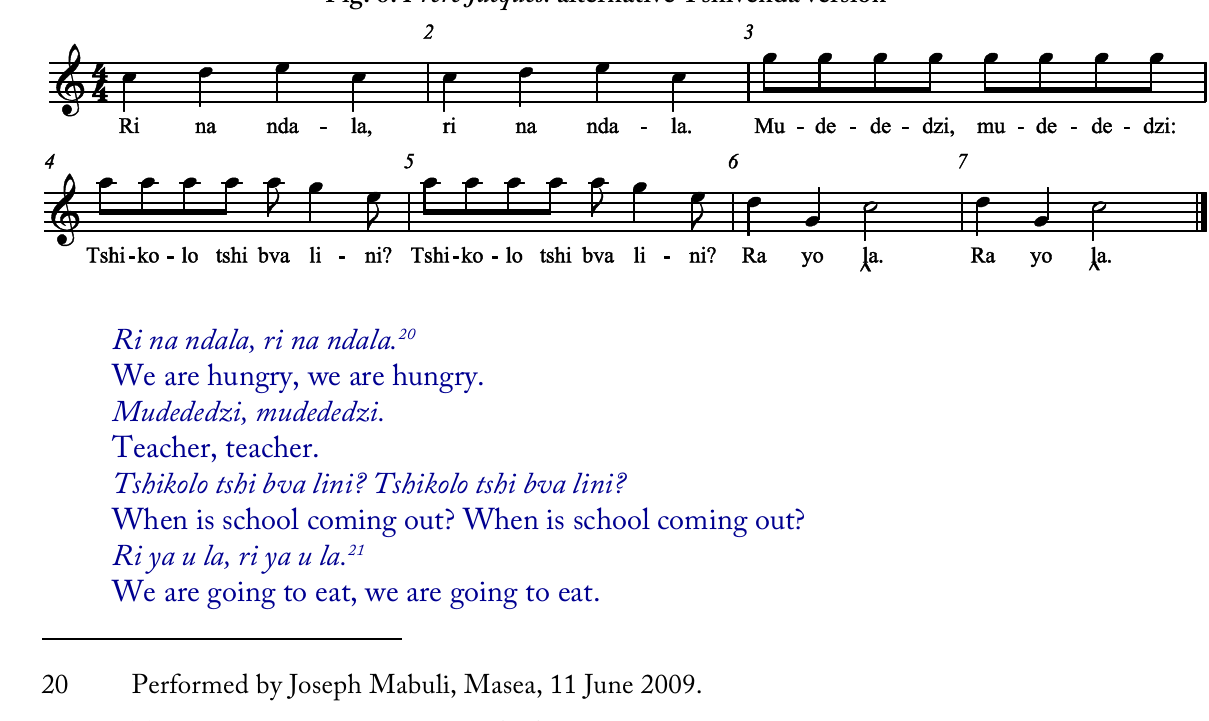
Fig. 6. Frère Jacques: alternative Tshivenda